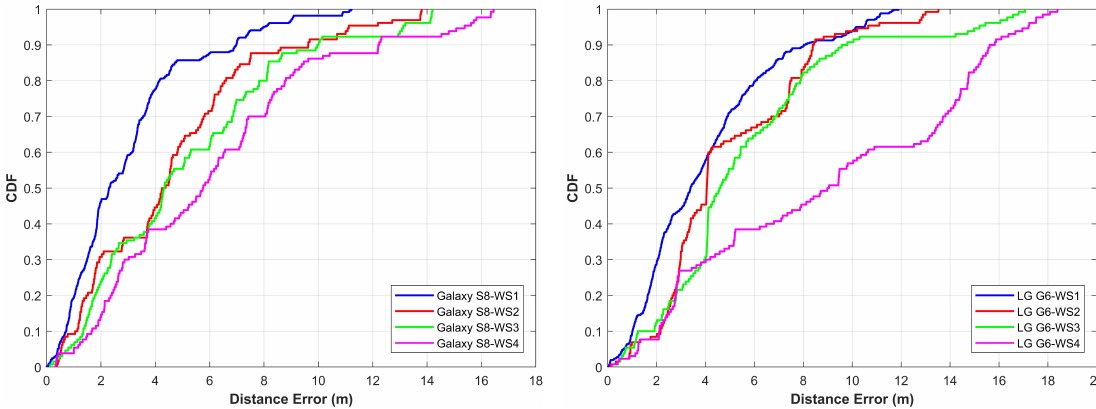
Figure 17. The cumulative distribution function (CDF) of Galaxy S8 and LG G6 for EE building.